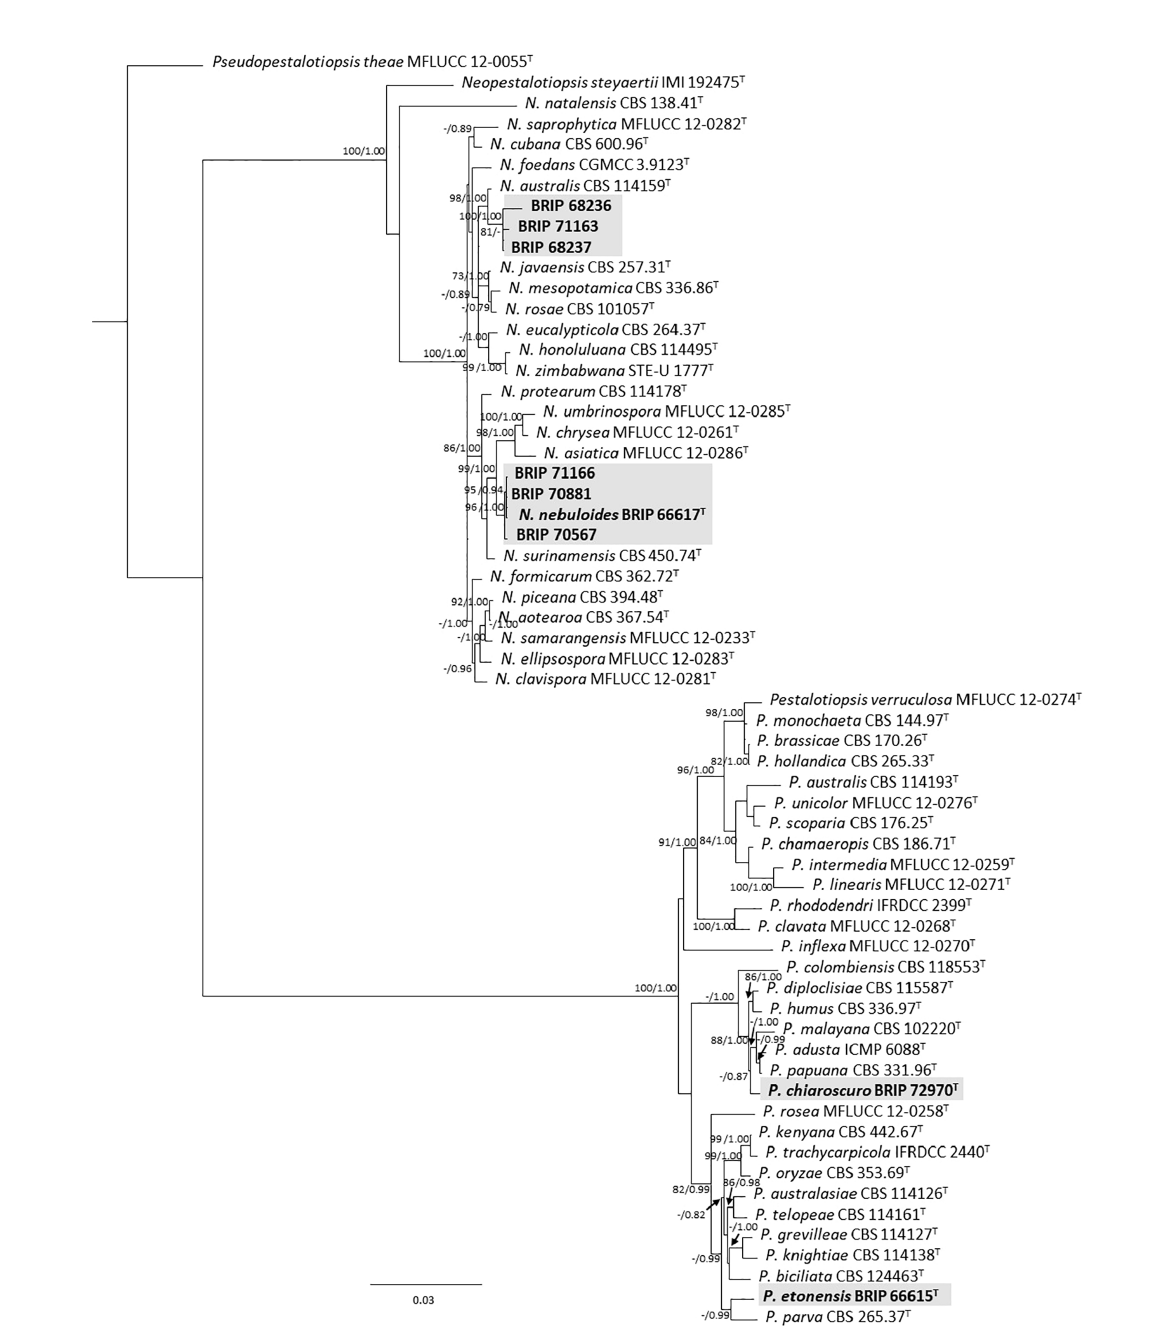
FIGURE 3 Phylogenetic tree inferred from a RAxML analysis based on a concatenated alignment of ITS, LSU, tef1- a and tub2 sequences of related genera from Pestalotopsidaceae (Amphisphaeriales). RAxML bootstrap (bs) values greater than 70% and Bayesian posterior probabilities (pp) greater than 0.8 are given at the nodes (bs/pp). In bold font are the isolates from this study, and ex-type strains are indicated with T